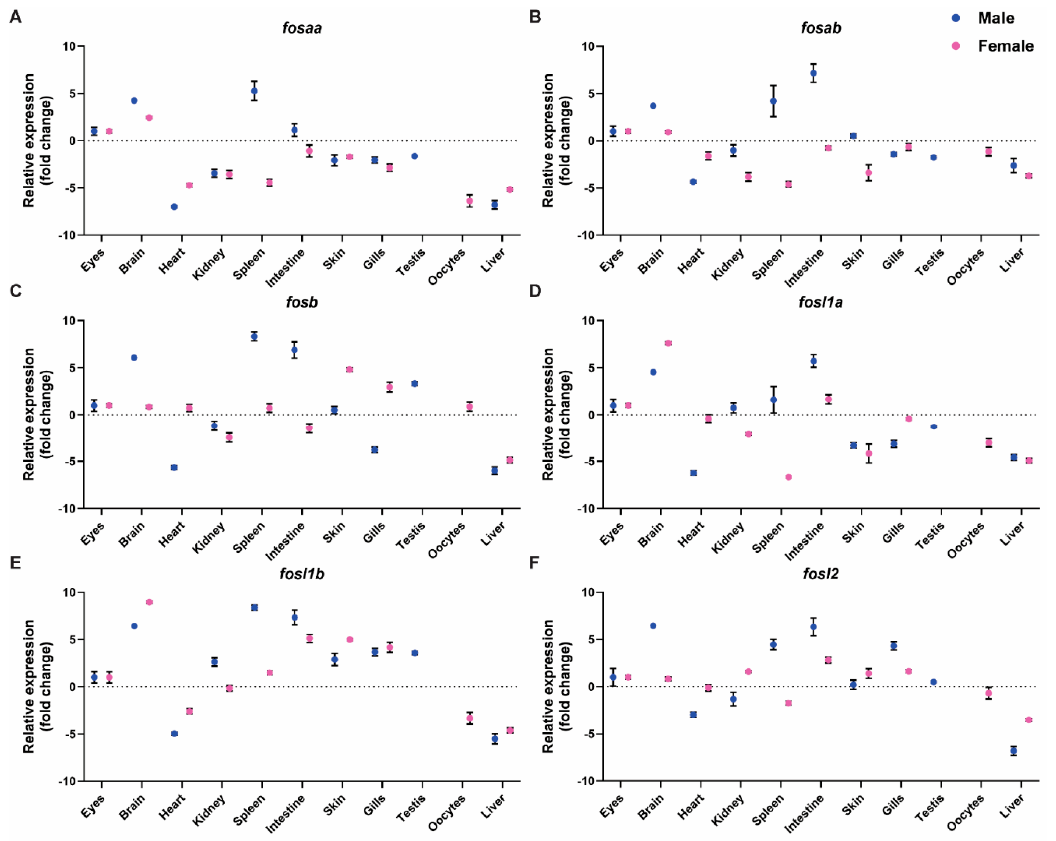
Figure 6. Relative expression of fos genes in male and female zebrafish adult tissues. mRNA expression levels of fosaa ( A ) , fosab ( B ) , fosb ( C ) , fosl1a ( D ) , fosl1b ( E ), and fosl2 ( F ) in zebrafish adult male tissues eyes, brain, heart, kidney, spleen, intestine, skin, gills, testis, and liver were determined by qRT-PCR. The relative mRNA levels were normalised to actb and ddct values determined by comparison with expression in the male eyes, the tissue with moderate expression. The black error bars indicate the standard error of mean for four biological replicates and the dotted line indicates the median in a tissue showing moderate expression.